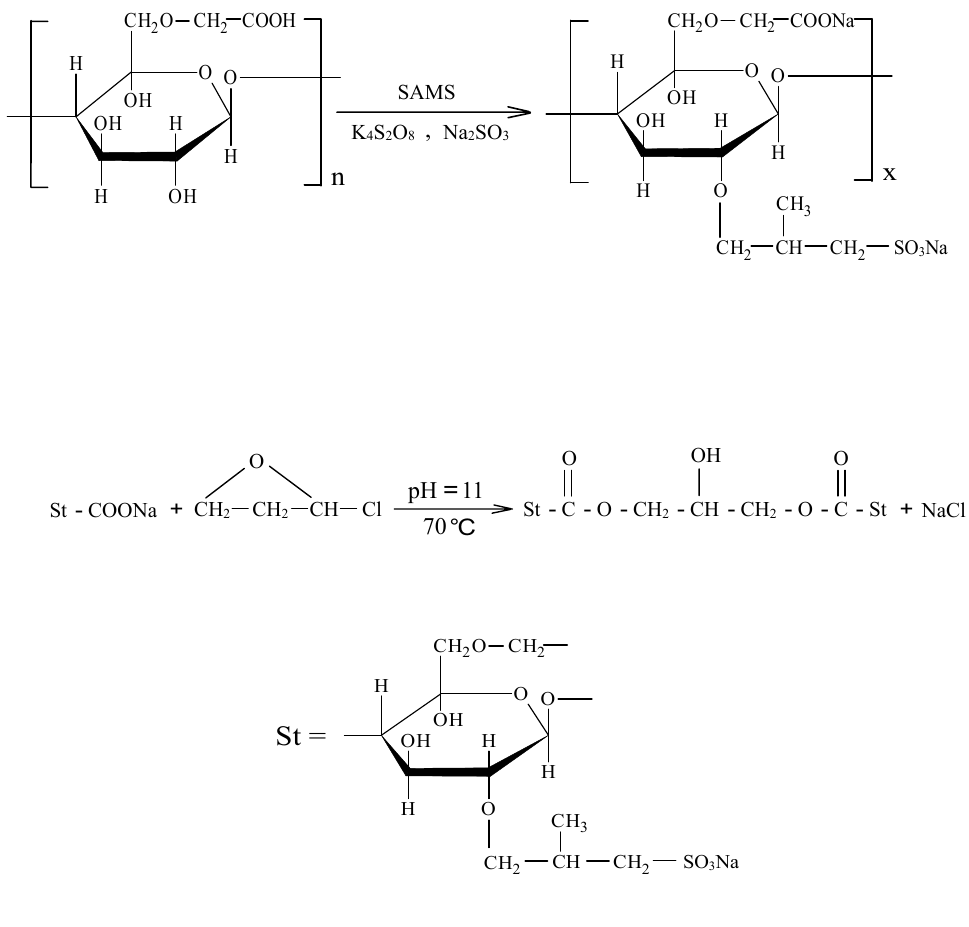
Fig. 5.A Process of grafting and crosslinking